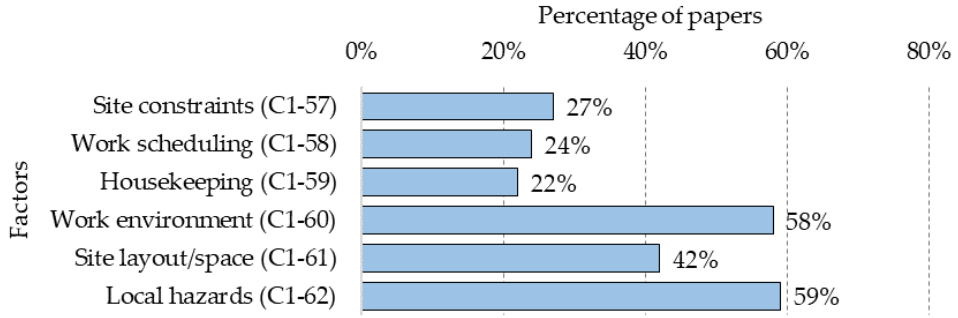
Figure 8. Percentage distribution of factors in the “Materials and equipment (B)” category.